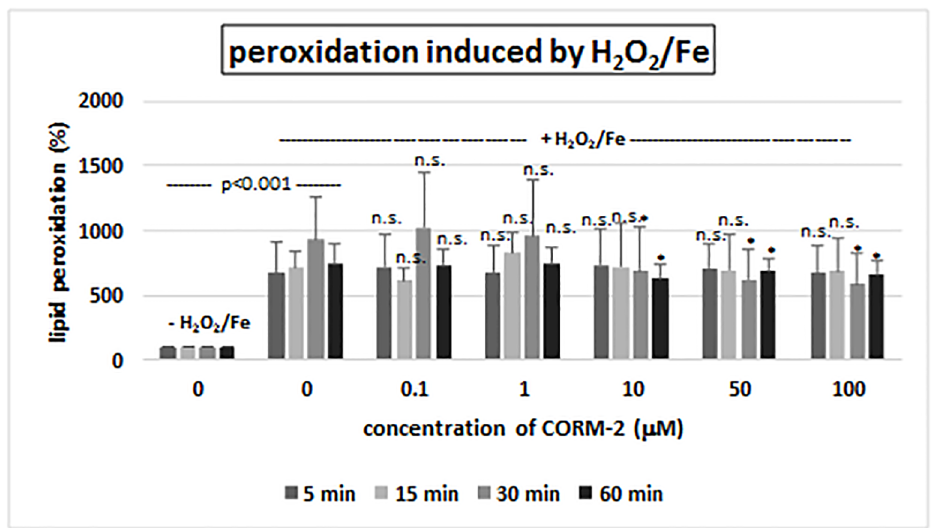
2 O 2 /Fe. Data representsmeans ± SD of 6 experiments (from different donors). * p < 0.05 vs . control (+ H